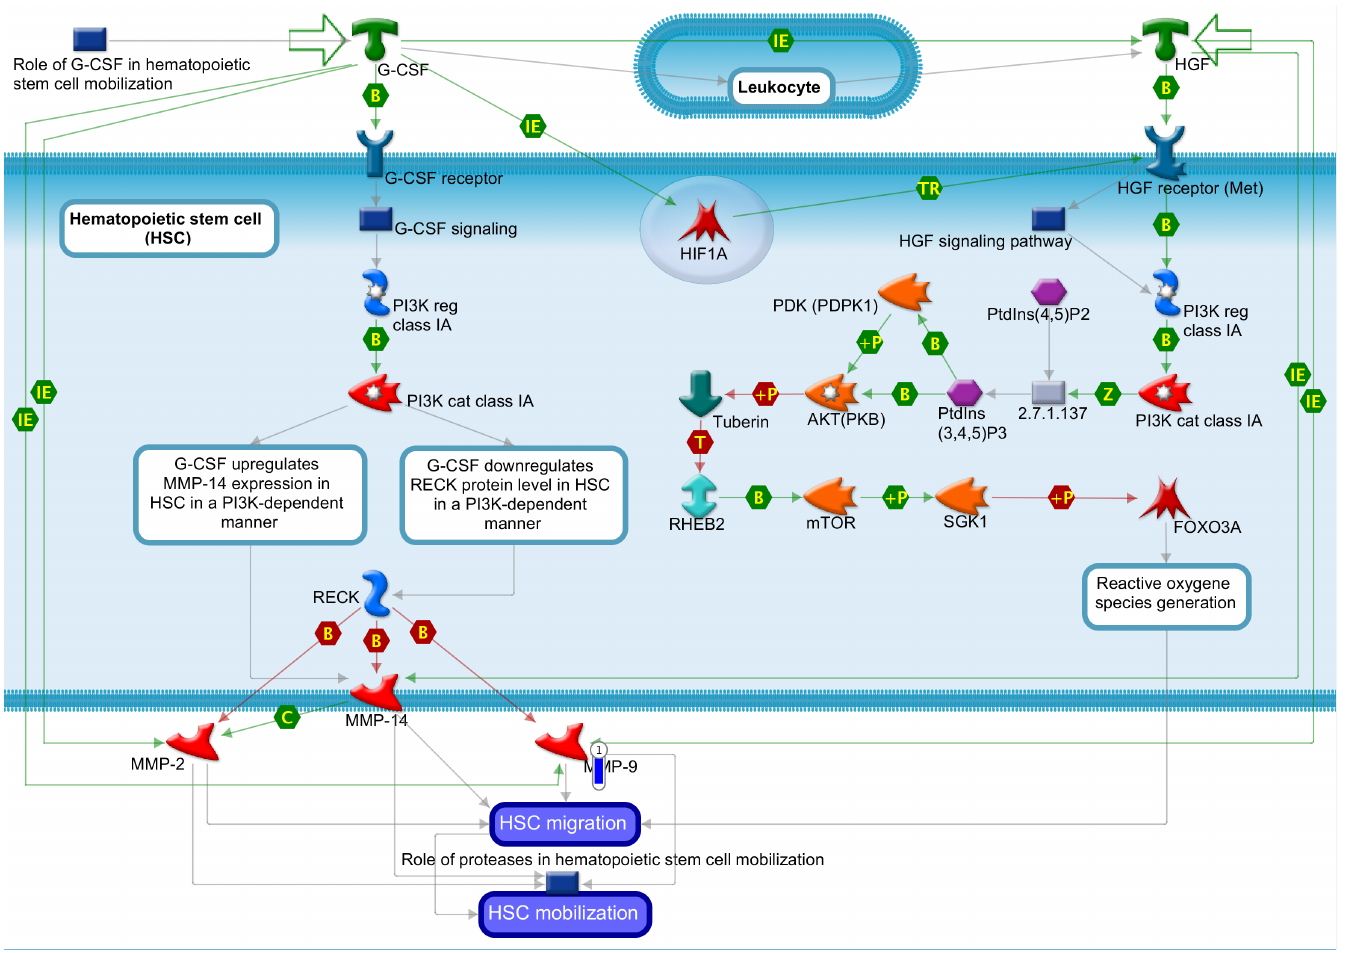
Fig 4. Canonical pathways under-expressed in BEN compared to non-BEN